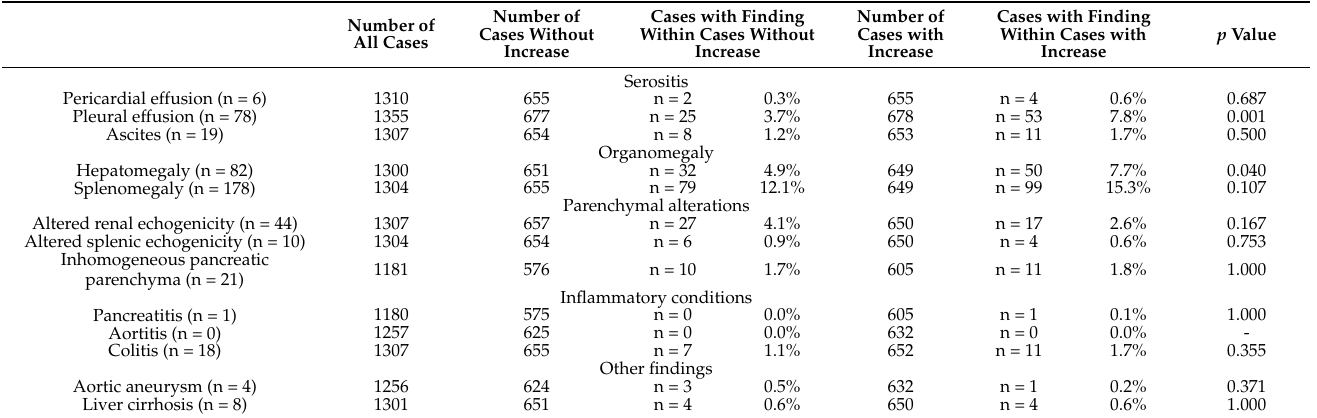
Table 4. Frequency of abdominal ultrasound findings in cases with versus without escalation of